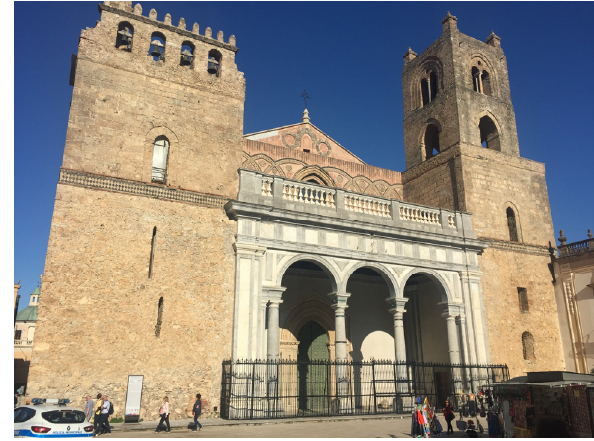
Figure 2. Main façade of Cathedral of Monreale